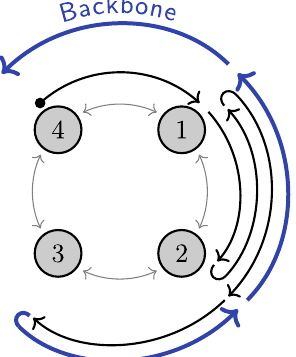
FIG. 3. Illustration of a single trajectory in a four-state Markov process where only transitions 4 → 1 ( þ ) and 1 → 4 ( − ) are visible. Thin gray arrows represent the possible transitions in state space, while thick arrows represent the trajectory. For this example, we define its associated “ backbone ” (blue thick arrows) by the sequence of the transitions last traveled between each pair of states that were visited in the trajectory: 3 → 2 , 2 → 1 , and 1 → 4 . See text for further